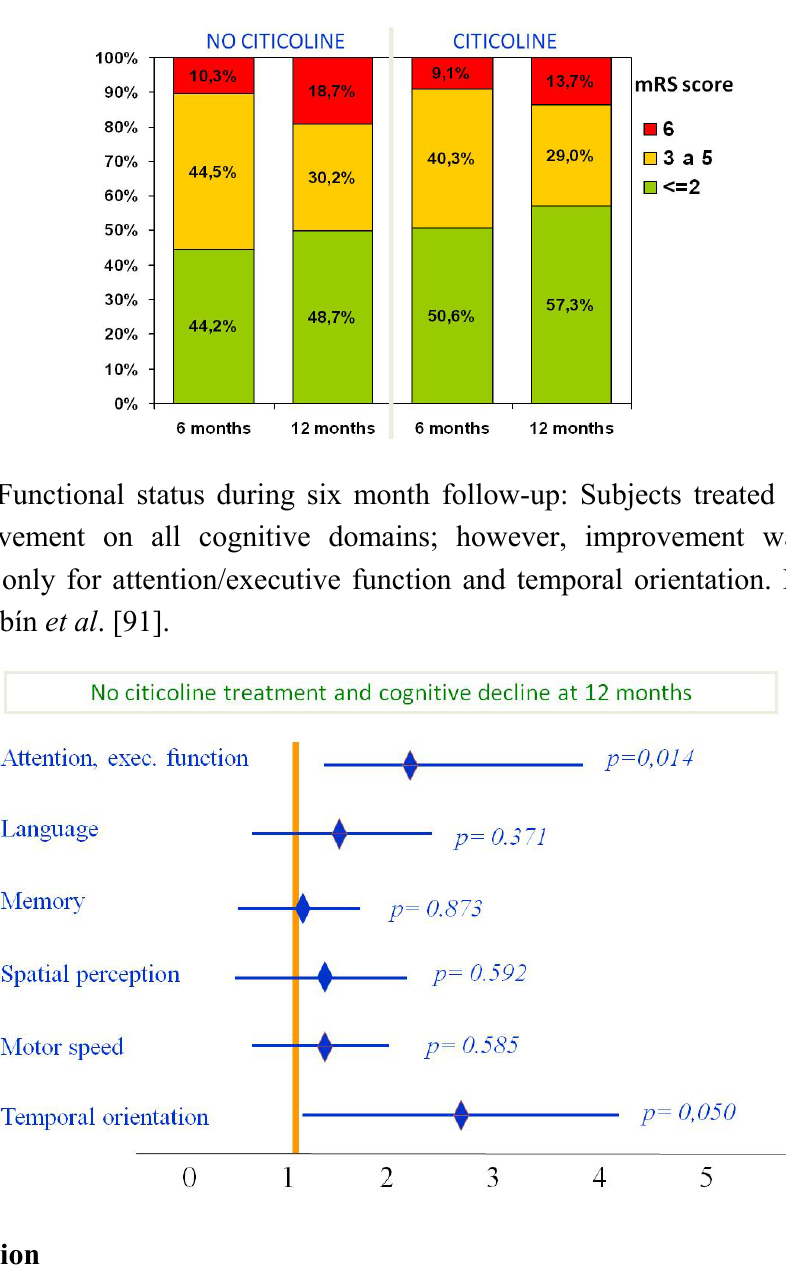
Figure 4. Functional status during follow-up: Notice the improvement in mRS scores (<2) at six and 12 months following stroke in the group treated with citicoline, compared with those untreated. From Álvarez-Sabín et al . [91].